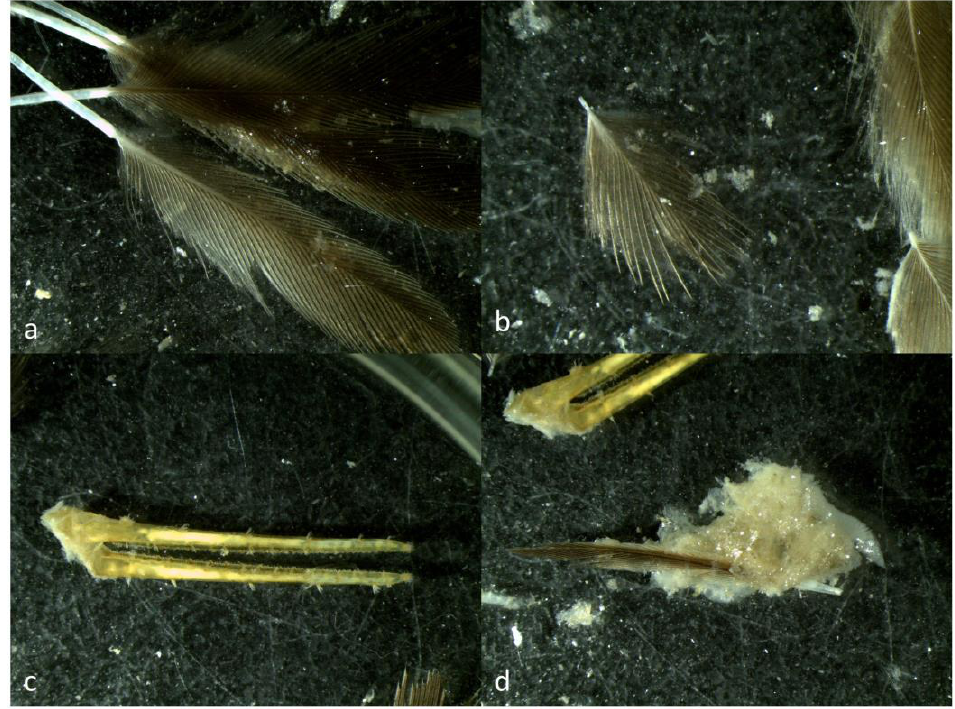
Figure 7. Evidence of the presence in stomachs of sea birds ( Mergus merganser Linnaeus, 1758): plumage remains ( a , b ), beak ( c ), and tissue remains ( d ).